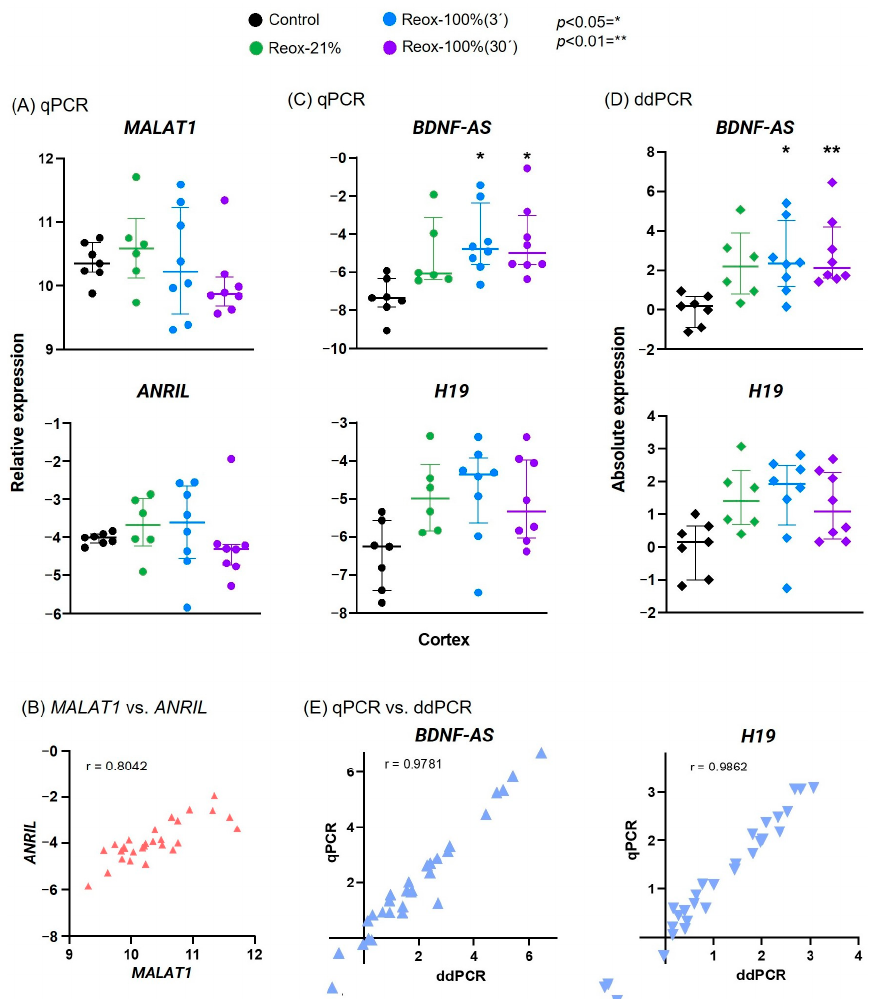
Figure 3. Hypoxia- and oxidative-stress-related lncRNAs after hypoxia and hyperoxic reoxygenation demonstrate expression differences between intervention groups. MALAT1 and ANRIL expression in the cortex analyzed via qPCR was likewise affected by the hypoxia and hyperoxia ( A ) and verified using Pearson correlation plot ( B ). Hyperoxic reoxygenation analyzed via qPCR resulted in a significant increase in only BDNF-AS , although H19 displayed a similar trend ( C ). When exposed to 30 min of hyperoxia, the increase in BDNF-AS expression was even more significant using ddPCR analysis ( D ). The expressions of BDNF-AS and H19 measured via qPCR and ddPCR were compared and revealed a strong positive correlation ( E ). Reox-21%, hypoxia and normoxic reoxygenation; Reox-100%(3´), hypoxia and 3 min hyperoxia; Reox-100% (30´), hypoxia and 30 min of hyperoxia; control group only received 21% O 2 . Data are shown on a logarithmic scale as 2 −∆ Ct and are expressed as either mean ± SD (qPCR: H19 ; ddPCR: BDNF-AS ) or median ± IQR (qPCR: BDNF-AS ; MALAT1 ; ANRIL ; ddPCR: H19 ).